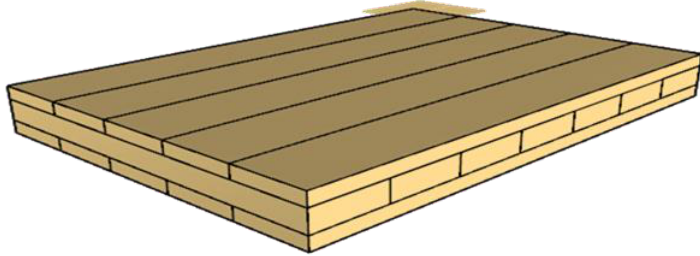
Figure 1. Cross-laminated timber panel.